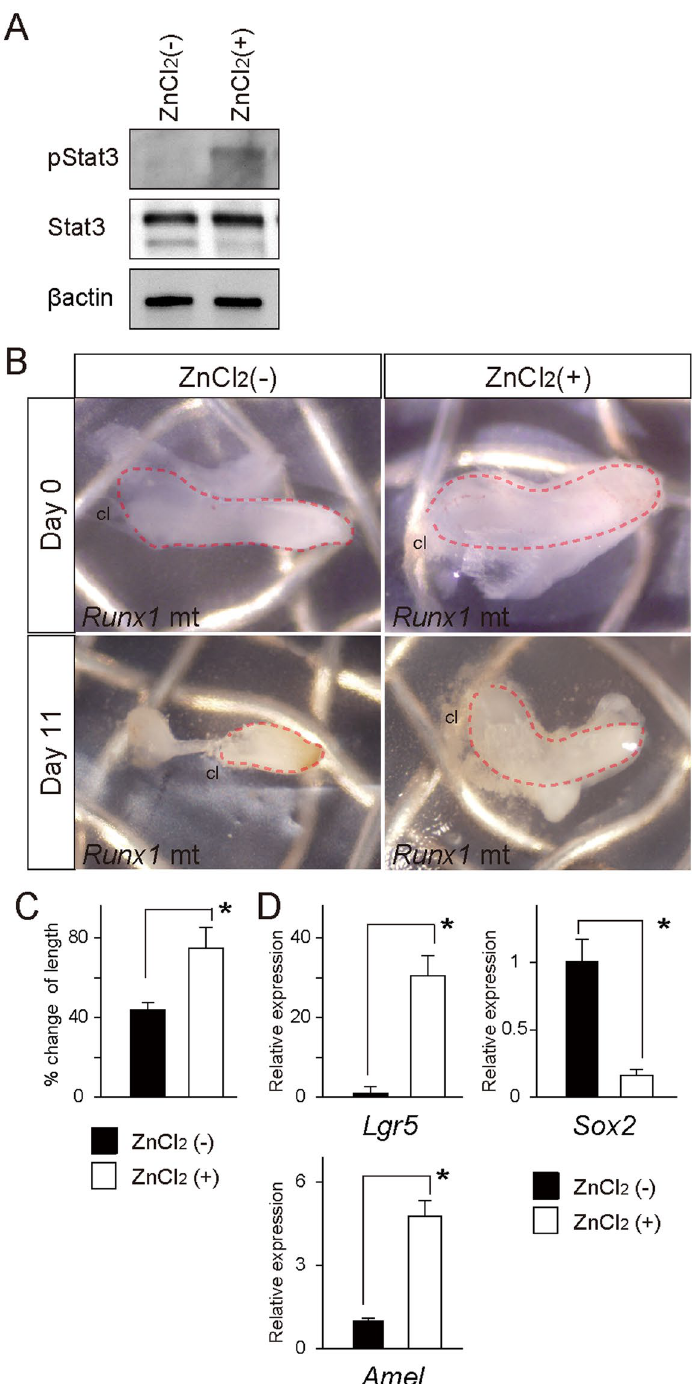
Figure 5. In vitro culture of the Runx1 mutant incisors and ZnCl 2 treatment ( A ) A Western blot analysis showed that the application of Stat3 activator of ZnCl 2 upregulated immunoreactivity to pStat3, but not to Stat3. ( B ) After 11 days of culture, the Runx1 mutant incisor explants became shrunk and bent, while the ZnCl 2 - treated Runx1 mutants were bigger than the mutants without ZnCl 2 -treatment. ( C ) The percent-change in the length of the explants revealed that ZnCl 2 treatment rescued the shrinkage of the mutant incisors. * p < 0.05. ( D ) A qPCR of the Runx1 mutant incisors demonstrated that ZnCl 2 treatment resulted in increases in the Lgr5 expression, while expression of Sox2 was downregulated. ZnCl 2 treatment also rescued the downregulated expression of Amelogenin and downregulated the Socs3 expression. * p < 0.05. cl, cervical